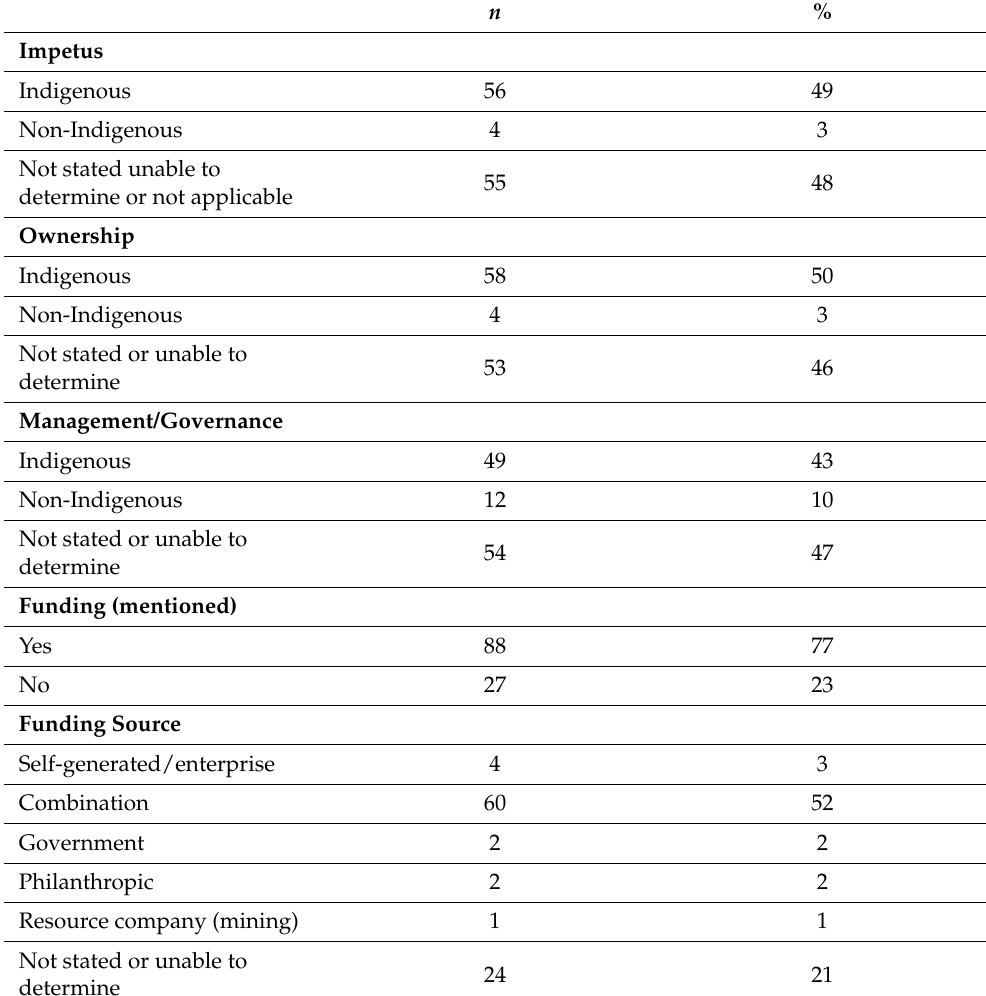
Table 3. Operational characteristics of Indigenous social enterprises ( n = 115). n